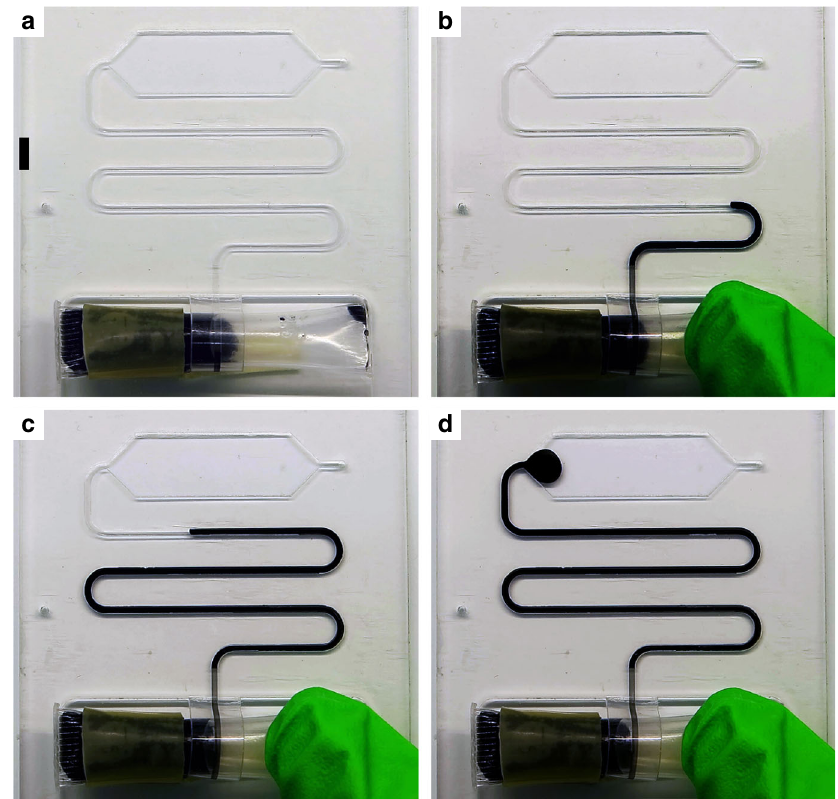
Fig. 4 Micro-dispenser for integrating with lab-on-a-chip devices. a A micro-dispenser connected to a micro-structure, the scale bar is 500 μ m, b actuating micro-dispenser by applying fi nger pressure, c applying further pressure, d stop applying